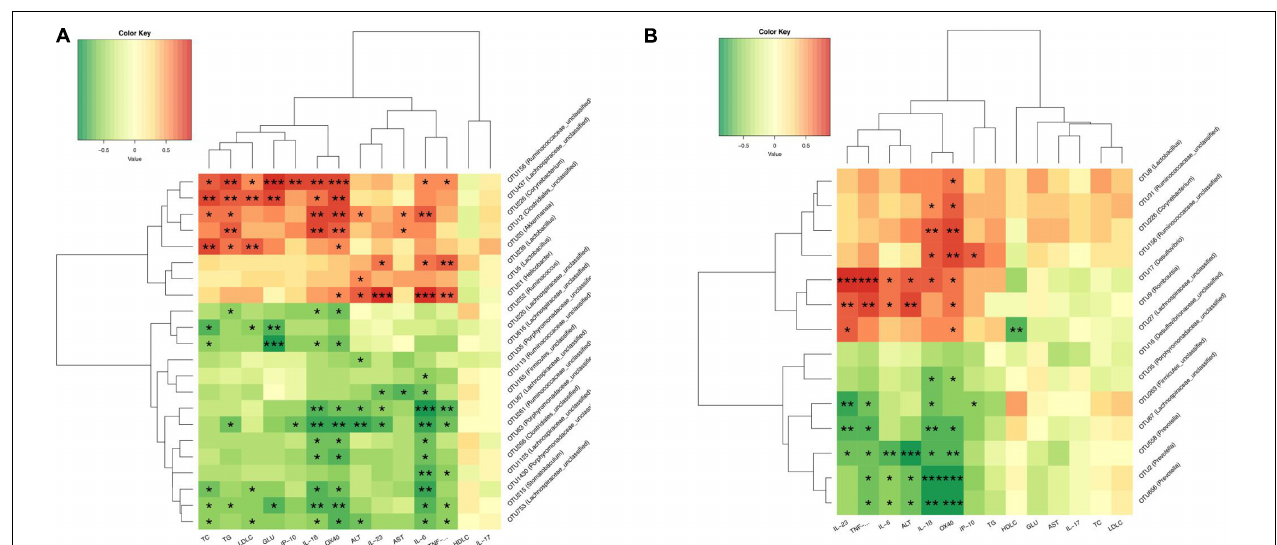
FIGURE 12 | CUR and MET-altered OTUs that were significantly correlated with host metabolic parameters. Spearman’s correlation analysis was performed between the OTUs which had significant difference among the HFD (14W), HFD + CUR (14W), and HFD + MET (14W) groups and specific metabolic parameters in all the groups of rats. (A) The correlation between the altered-OTUs and host metabolic parameters between the HFD (14W) and HFD + CUR (14W) groups. (B) The correlation between the altered-OTUs and host metabolic parameters between the HFD (14W) and HFD + MET (14W) groups. Rows correspond to OTUs with the identities shown on the right and columns correspond to metabolic parameters. Red and green colors indicate positive and negative association, respectively. The intensity of the colors represents the degree of association between the OTU abundances and host parameters as assessed by the Spearman’s correlations analysis. The asterisks indicate that the associations were significant. The taxonomy of the OTUs is shown on the